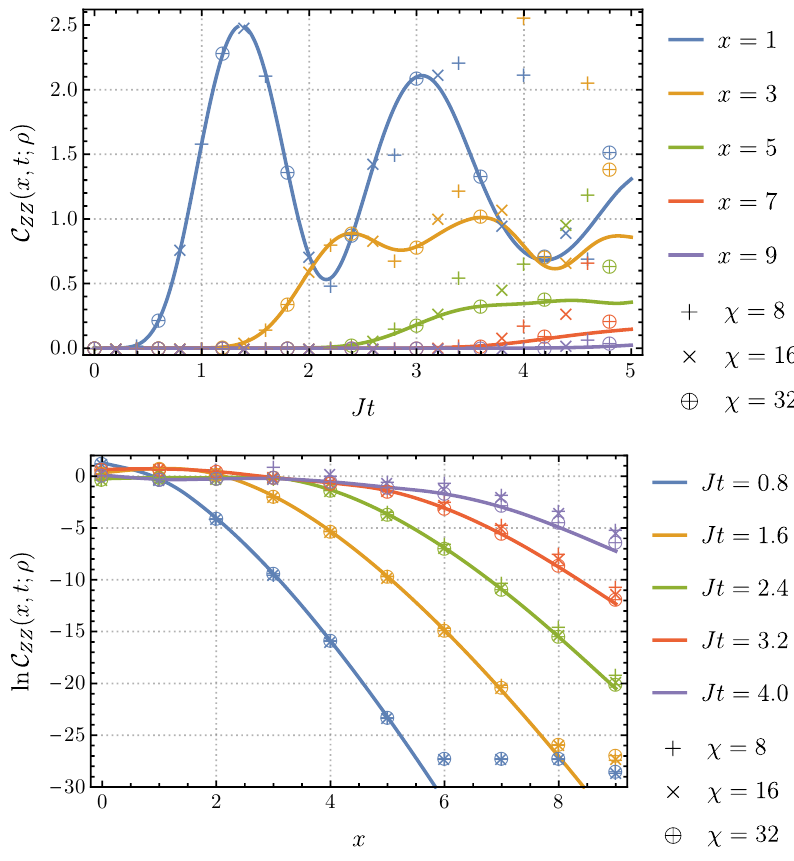
Figure 4: Comparison with Exact Diagonalization. The solid curves are from ED numerics in a mixed field Ising chain with N = 10, h (21) for the Hamiltonian) and ρ is the thermal state with T = J . In the first panel, each curve shows the time dependence of the OTOC at a fixed distance ( O = Z O ). For finite bond dimension truncations χ = 8,16 and 32, the MPO result x + 1 2 agrees with ED at early times, and starts to deviate when the truncation is reached, which is near J t = 2,3 and 4 respectively. In the second panel, each curve is a spatial profile of the OTOC at a fixed time. Propagation of a butterfly wavefront is clearly observed. For all χ the agreement with ED is remarkable until the MPO truncation (cid:34) = 10 − 14 kicks in after ln C drops to approximately −